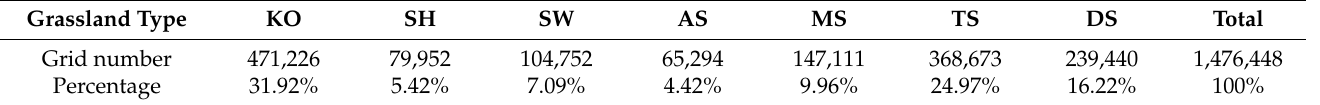
Table 2. The grid numbers for all grassland subtypes and their proportions in the total grid.